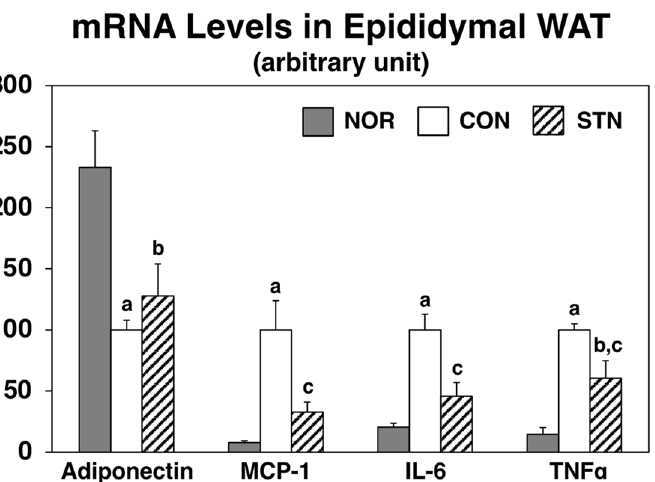
Figure 4. Expression levels of adipocytokine mRNAs in epididymal white adipose tissues of C57BL/6J and db/db mice fed experimental diets for 4 weeks. Values are expressed as the mean ± standard error ( n =5). a Significant difference at p < 0.05 between NOR and CON; b significant differ- ences at p < 0.05 between NOR and STN; c significant differences at p < 0.05 between CON and STN.